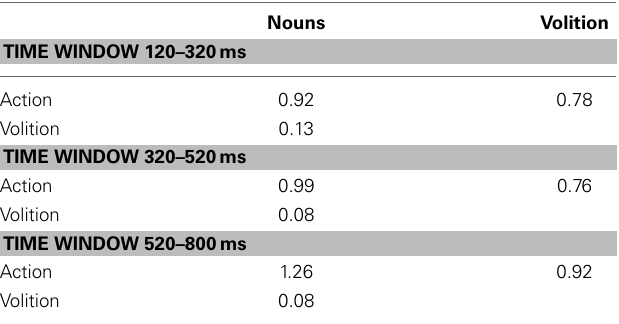
Table 3 | Cohen’s d for the differences between the various conditions in the three time